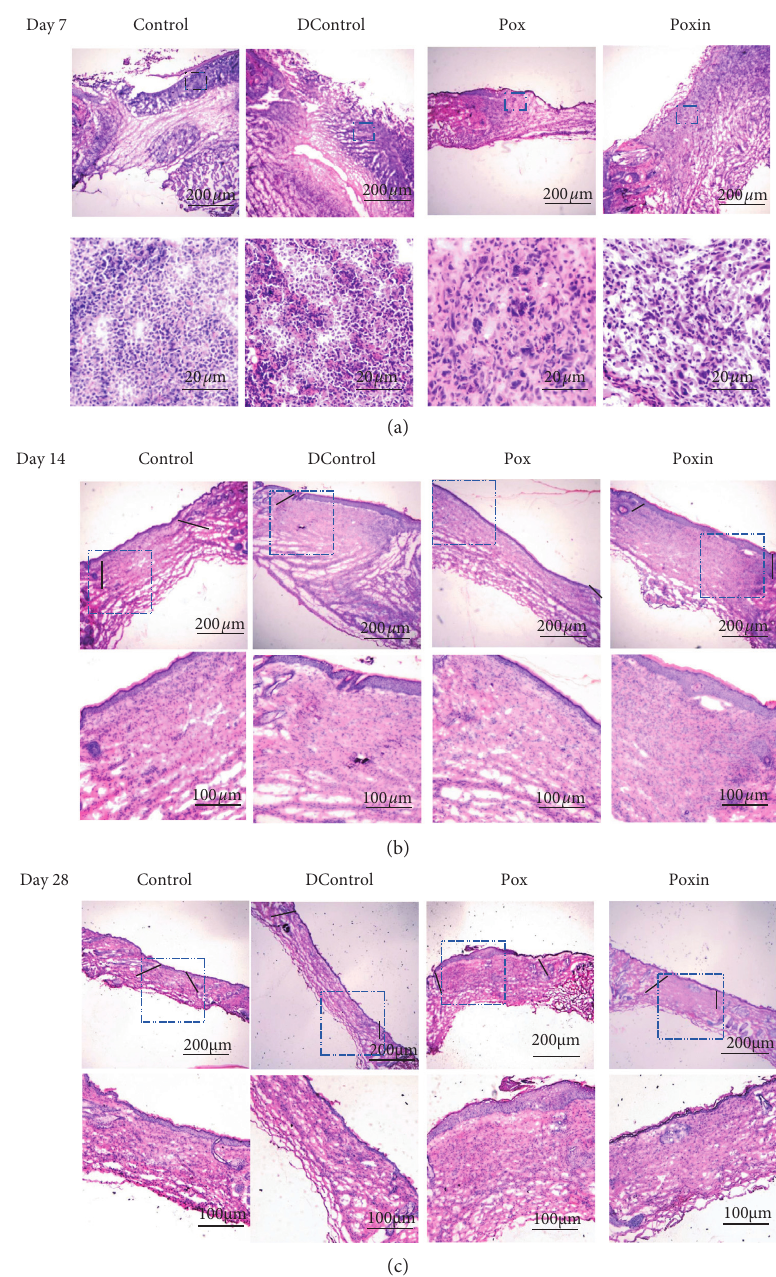
Figure 5: Histological photographs of a full-thickness nonsutured skin wound: Control, DControl, Pox, and Poxin groups at days 7, 14, and 28 after operation, respectively. Below figures are the magnifications of square zone on the up figures at the same day time. The black lines point the wound